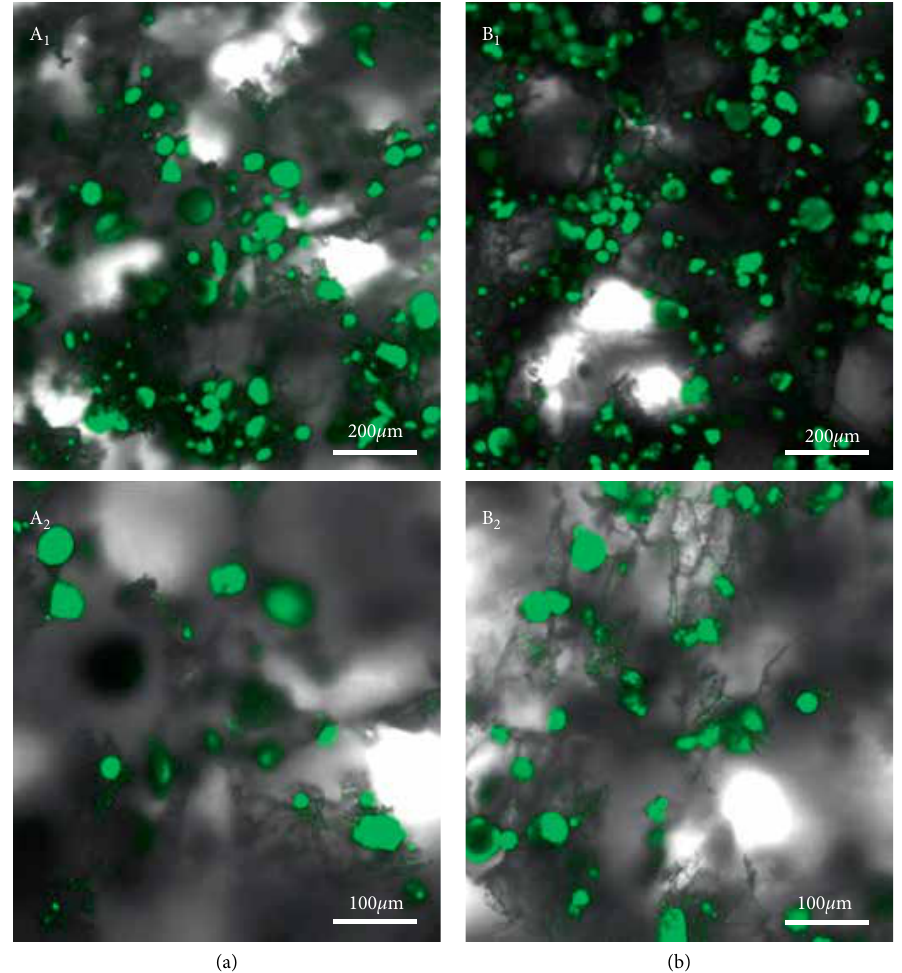
Figure 4: CLSM images of Evans blue loaded TCP@GMs/ b- PLGC scaffolds of (a) E-M/P50 and (b) E-M/P70.